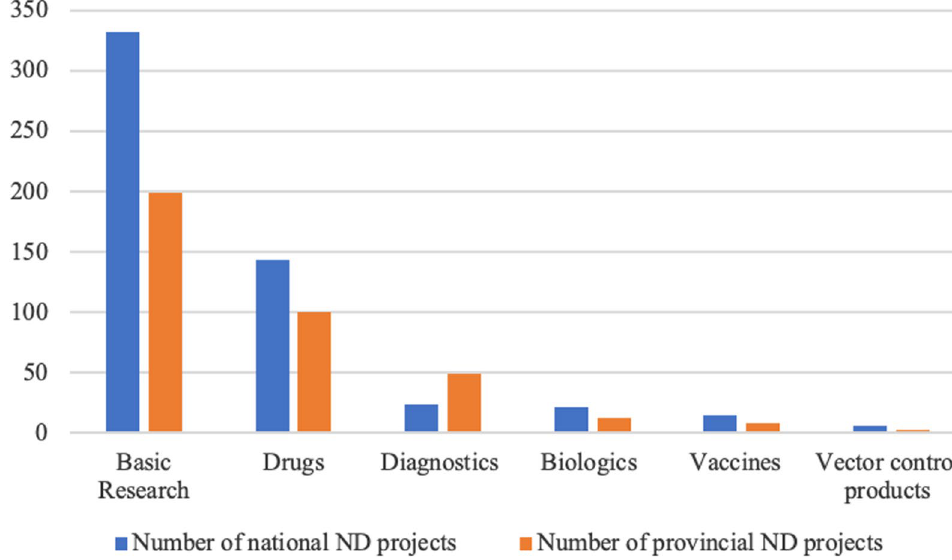
Fig. 4 Total number of 2017–2019 national and provincial ND projects by research